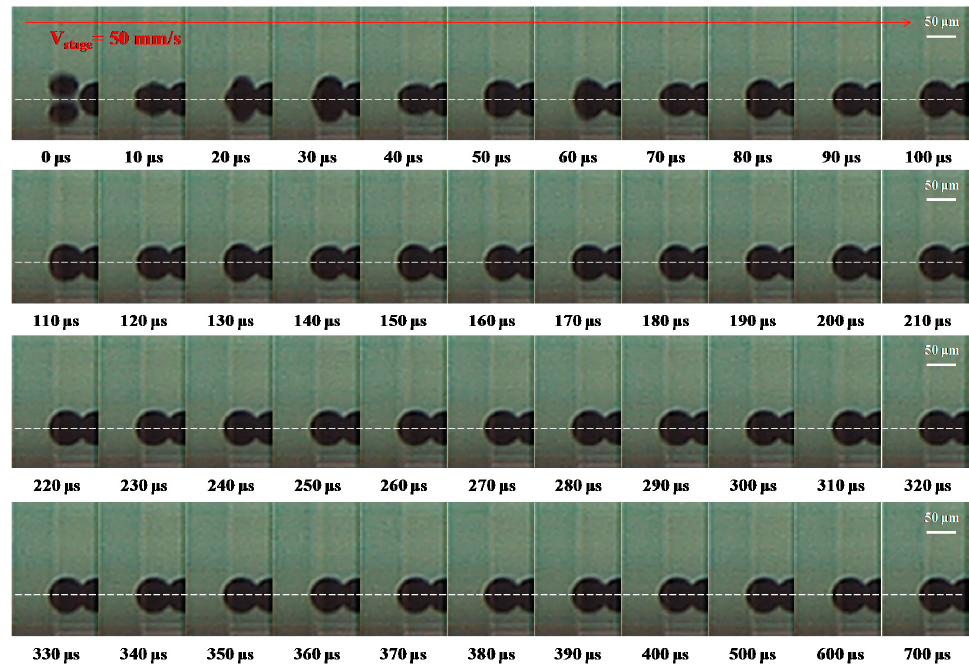
Figure 7. The deposition of a molten metal droplet under a stage velocity of 50 mm ∙ s − 1 (frequency = 1000 Hz) with the following initial characteristics: diameter D 0 = 50 μ m, velocity = 1.1 m ∙ s − 1 , dot spacing = 50 μ m, and sample temperature 30 °C (We = 0.92, Re = 206.25, Oh = 4.7 × 10 − 3 , Ste = 0.722). Evolution of the incoming droplet (the second one) impacting onto a gold-plated glass substrate recorded using a high-speed digital camera with condition D in Table 2. The dashed lines separate the outline of the droplet from that of its reflection on the substrate. The scale bars are 50 µ m.